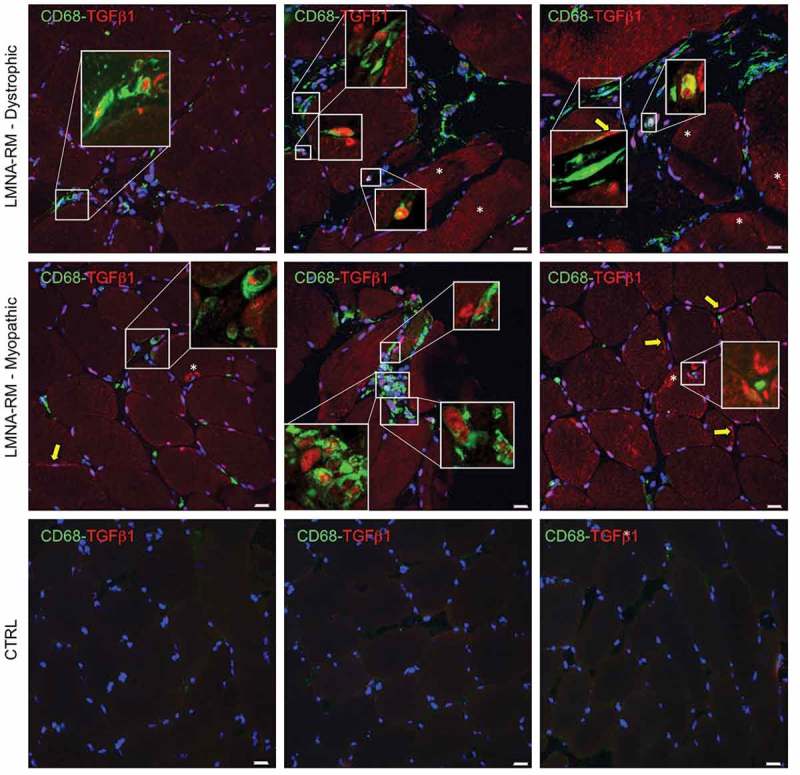
Expression and localization of TGF-β1 in LMNA-RM muscle tissue. Double immunofluorescence showed a TGF-β1 (red) positive staining subjacent to sarcolemma (yellow arrows) or in the sarcoplasm (white asterisks) of some muscle fibers (mean ± SD: 31.64% ± 11.50). A TGF-β1 positive immunoreactivity was observed in the majority of CD68 (green) positive macrophages (mean ± SD: 67.60% ± 5.62), as shown in the insets. Absence of CD68 and/or TGF-β1 staining was observed in non-myopathic muscles (CTRL). Original magnification, X40 and X120 in the insets; bars 20 μm.